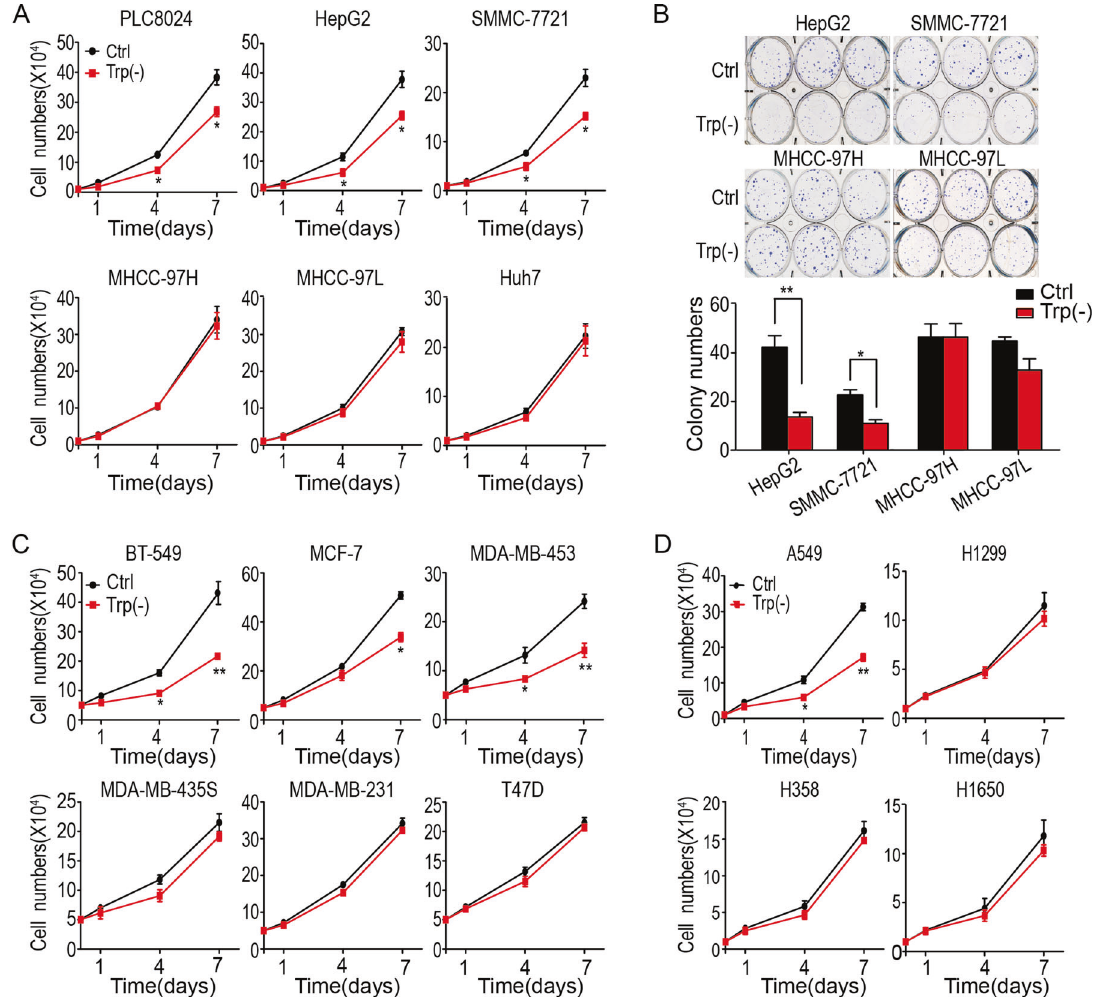
Fig. 1 Tryptophan de fi ciency suppresses the growth of some cancer cells. A The effects of tryptophan de fi ciency on HCC cells growth were analyzed by cytometry assay. ** P < 0.01; * P < 0.05. B The effects of tryptophan de fi ciency on HCC cells growth were analyzed by colony formation assay. ** P < 0.01; * P < 0.05. C The effects of tryptophan de fi ciency on breast cancer cells growth were analyzed by cytometry assay. ** P < 0.01; * P < 0.05. D The effects of tryptophan de fi ciency on lung cancer cells growth analyzed by cytometry assay. ** P < 0.01; * P < 0.05. Trp